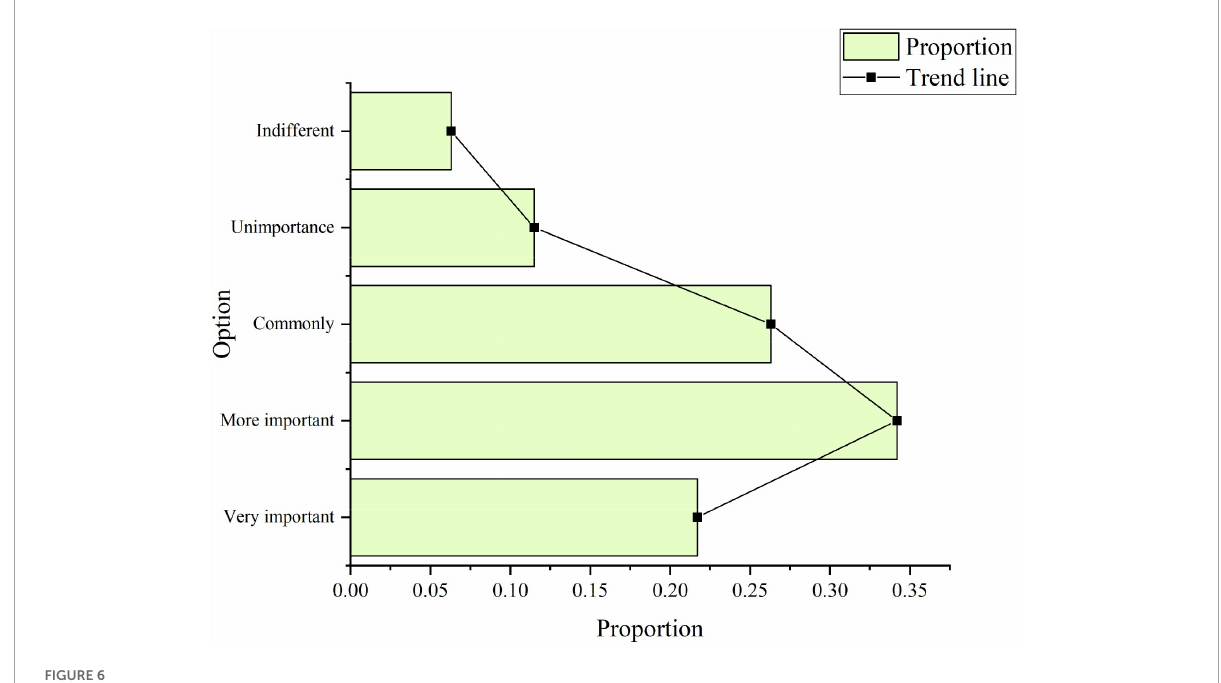
FIGURE6 Investigation on the importance of sports culture construction.